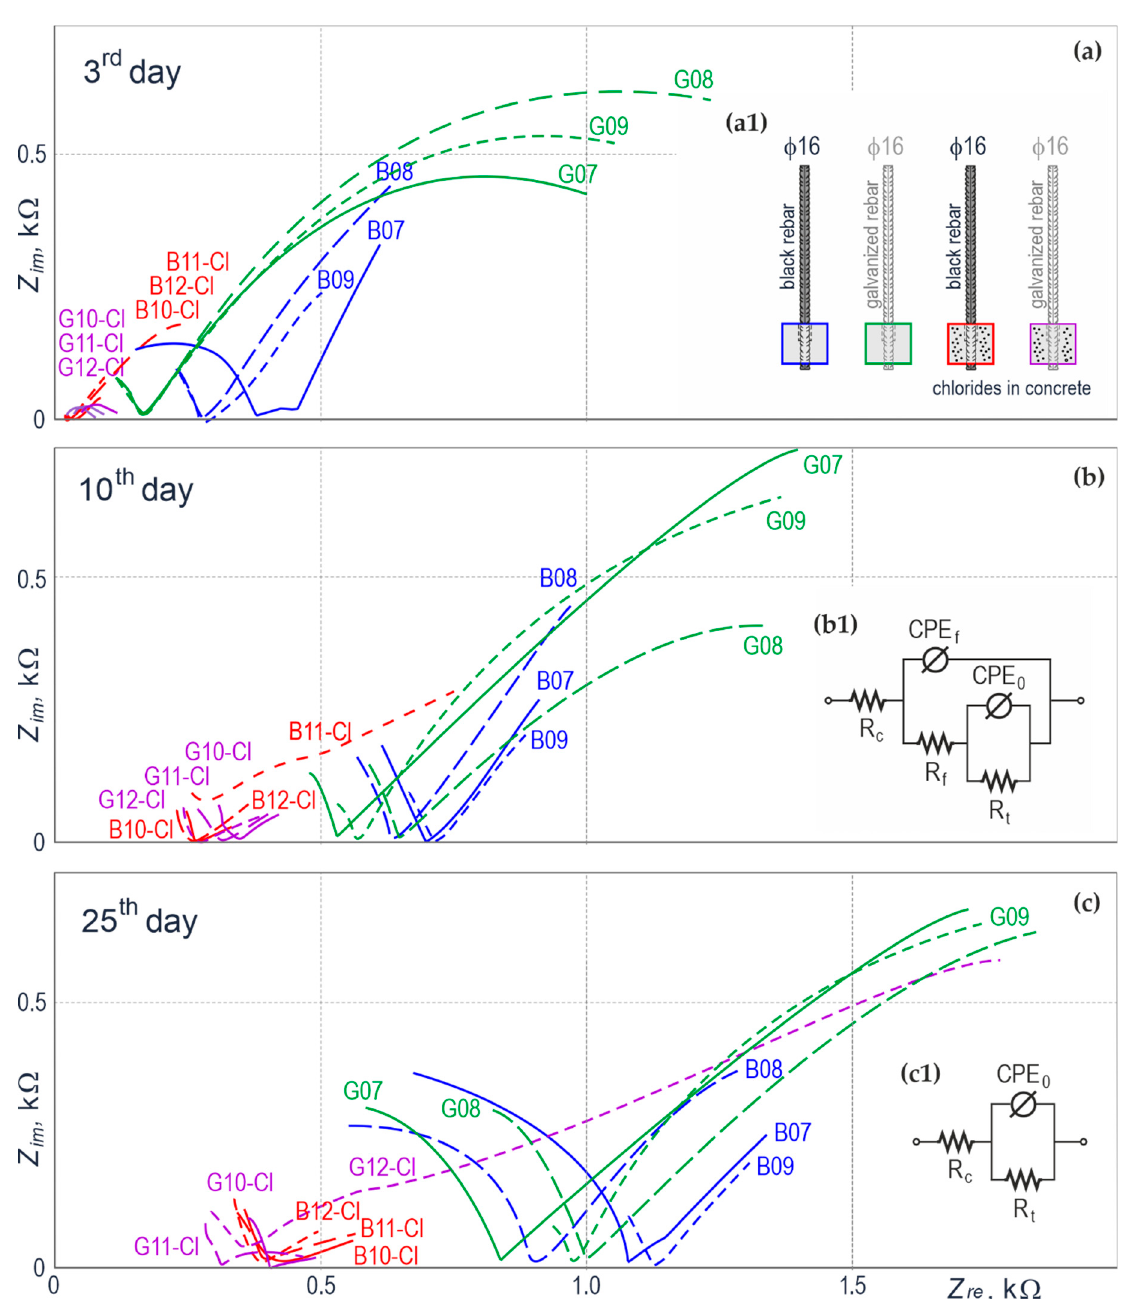
Figure 9. Impedance results on the Nyquist plot for ribbed rebars ϕ 16 mm embedded in the concrete specimens: ( a ) the measurements on day 3 of concrete hardening in the specimens, ( a1 ) 4 types of the elements tested with EIS, the colour of concrete paver outline corresponded to the colours of impedance spectra, ( b ) the measurements on day 10 after setting the specimens in concrete, ( b1 ) equivalent electrical circuit for analysing the spectra of steel in concrete with chlorides, ( c ) the measurements on day 25 after setting the specimens in concrete, ( c1 ) equivalent electrical circuit for analysing the spectra of steel in concrete without chlorides.